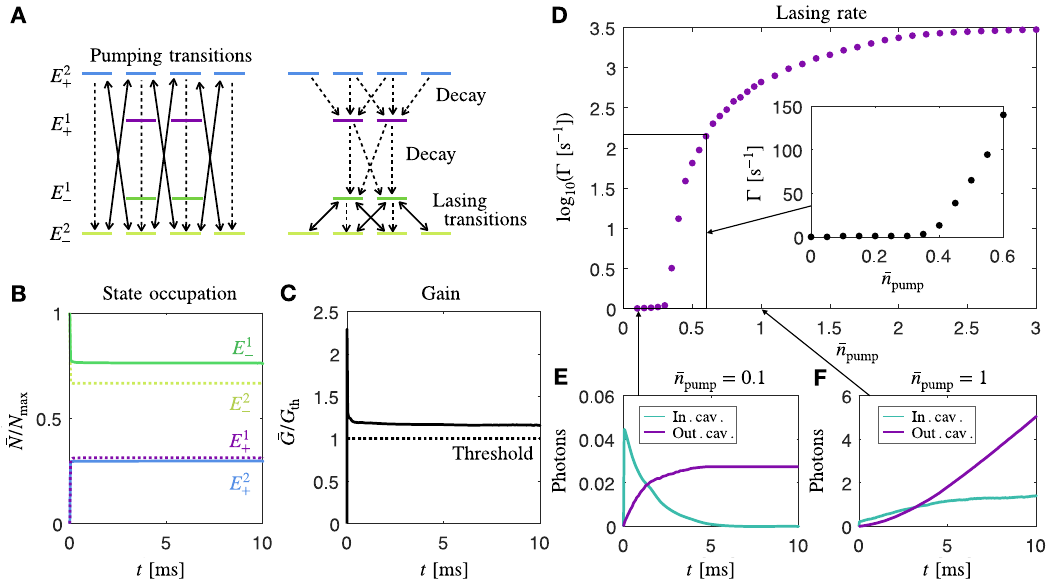
Figure 4: TQD lasing: (A) schematic of all lasing scheme transitions. Solid lines denote stimulated processes (and downwards spontaneous = 0, ̄ n = 1. processes) and dashed lines denote spontaneous processes only. (B) Evolution of normalised state occupation for E F pump Population inversion between energy levels E 1 and E 2 is demonstrated and (C) gain above threshold for this transition is demonstrated. (D) − − with inset showing low pumping regime Steady-state lasing rate (coherent photons emitted from cavity per second) for varying ̄ n pump ≤ 0 . 6, with a lasing threshold of ∼ 0 . 35. (E) shows the number of coherent photons inside the cavity andemitted from the cavity as 0 ≤ ̄ n pump = 0 . 1, which is below the lasing threshold and (F) ̄ n = 1 which is above the lasing a function of t for ̄ n pump pump